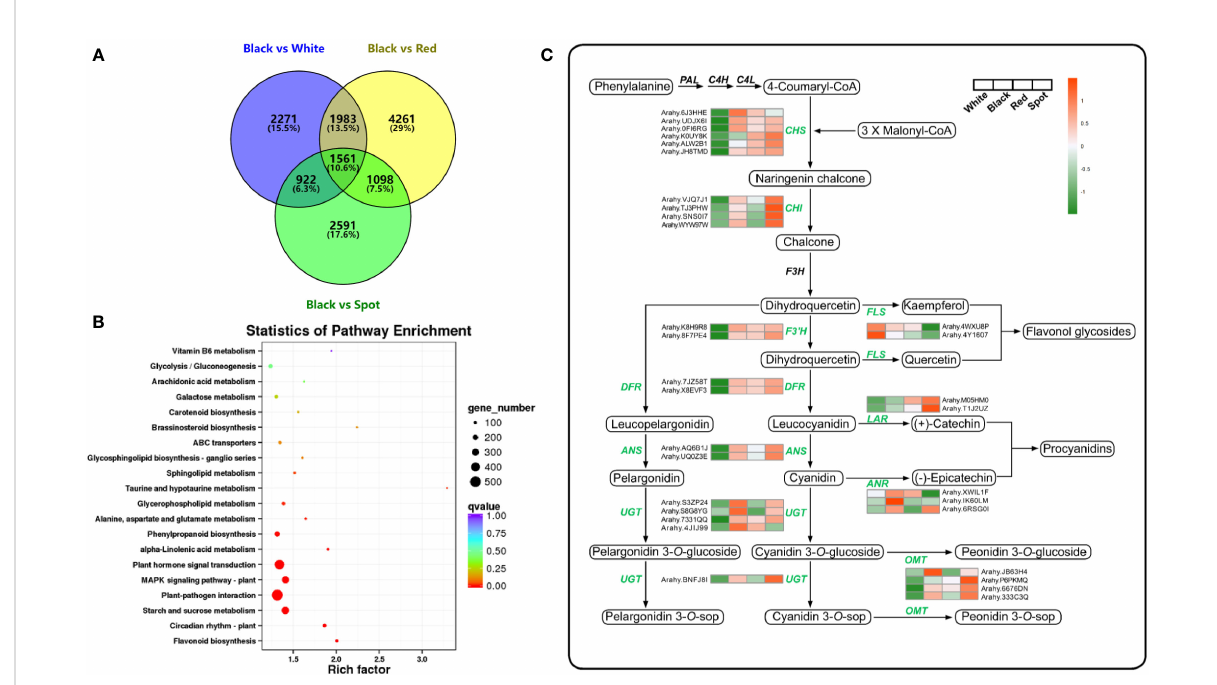
FIGURE 4 Transcriptome analysis of peanut seed coats with different color. (A) Venn diagram of differentially expressed genes (DEGs) between black peanut testa and other samples. (B) Pathway enrichment analysis of all DEGs. The dots represent the number of signi fi cant DEGs, the dots with different colors indicate different q-values. (C) Transcriptional expression pattern of structural enzyme genes involved in fl avonoid biosynthetic pathway. The values in the heatmap represent the z-score of the FPKM values (transcript levels) in different samples. Orange color indicates high expression level, while green is